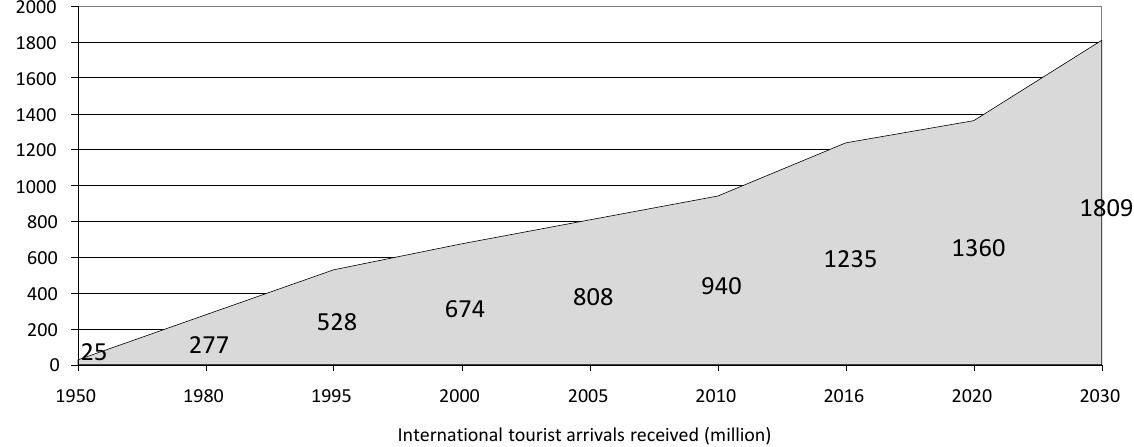
Figure 1. Dynamics and forecast indicators of the development of tourist activity in the world according to the number of arrivals